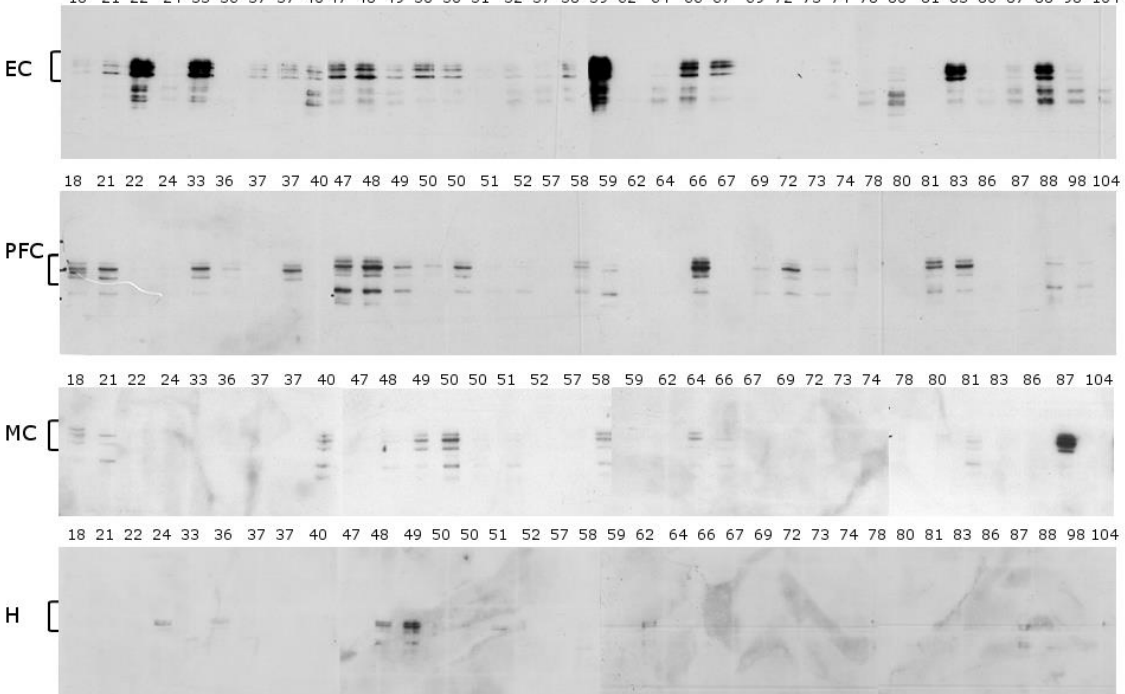
Figure 3. Soluble Tau using a mid-sequence antibody. Western blot analysis using an antibody raised to an epitope in the middle of Tau. The soluble fraction was probed with an antibody specific to the mid-sequence of Tau (Figure 1) in five brain regions: the entorhinal cortex (EC), prefrontal (PFC), motor cortex (MC), and hippocampus (H). The ages are displayed above each lane. Brackets correspond to the migration zone of the full sequence Tau isoforms. The cerebellum is not displayed due to the lack of immunoreactivity in this region.